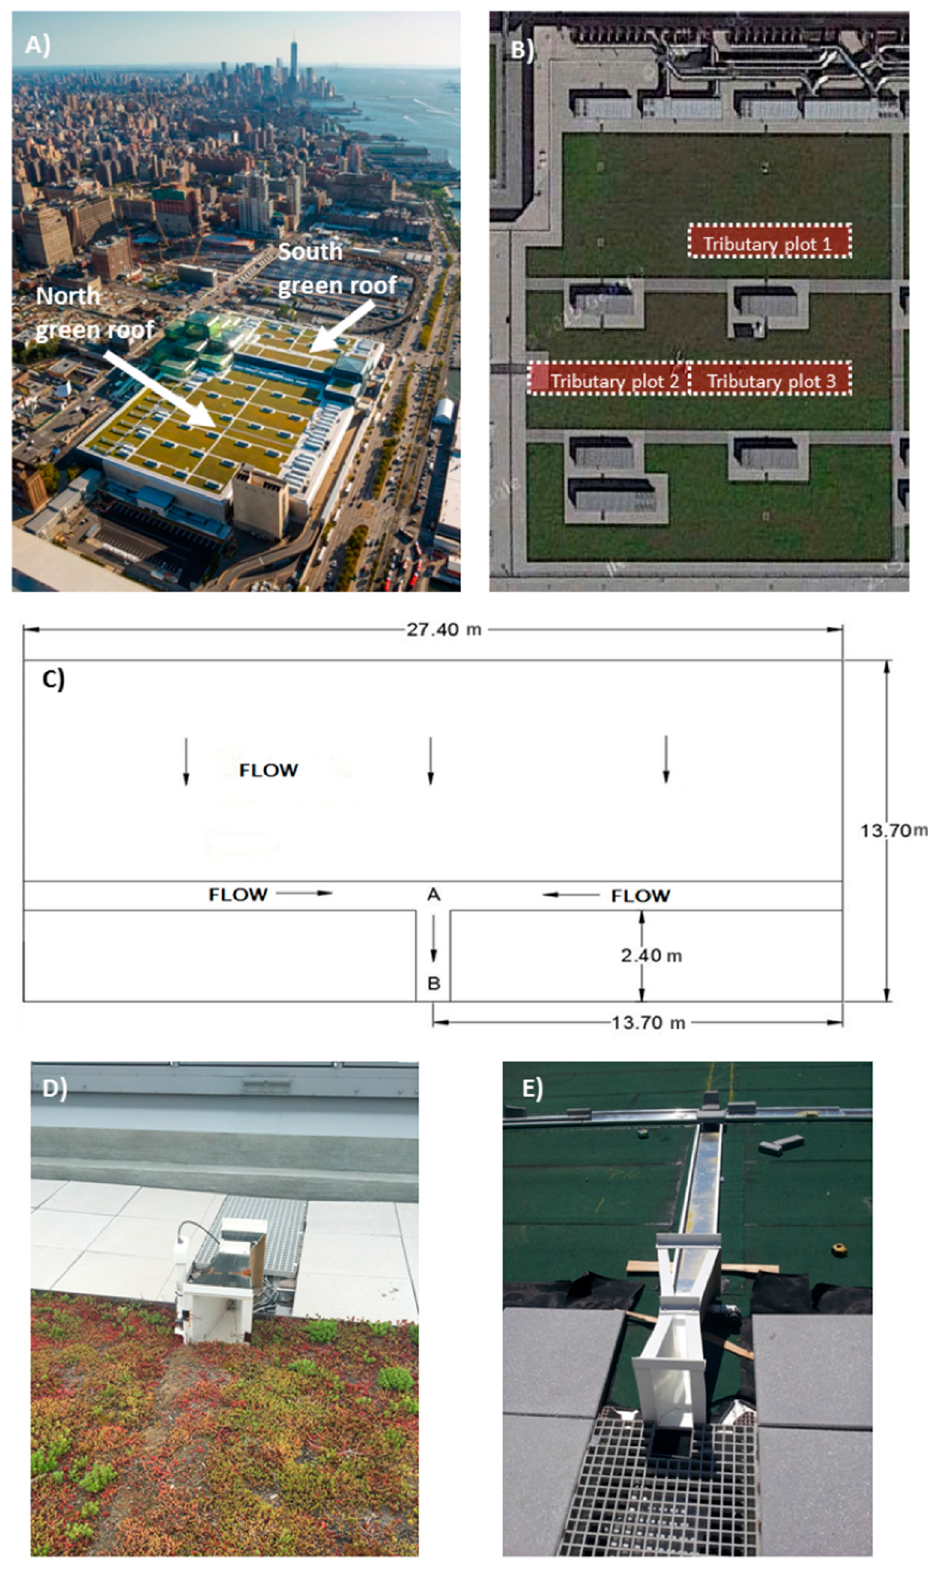
Figure 1. ( A ) aerial view of the Javits Green Roof (JGR); ( B ) the three 186 m 2 tributary areas on the south roof used for runoff collection; ( C ) flow pathways in each of the three tributary areas; ( D ) view of the end of the tributary area (point B in 1C), where it discharges into the flume; and ( E ) the flume and channel system under construction.